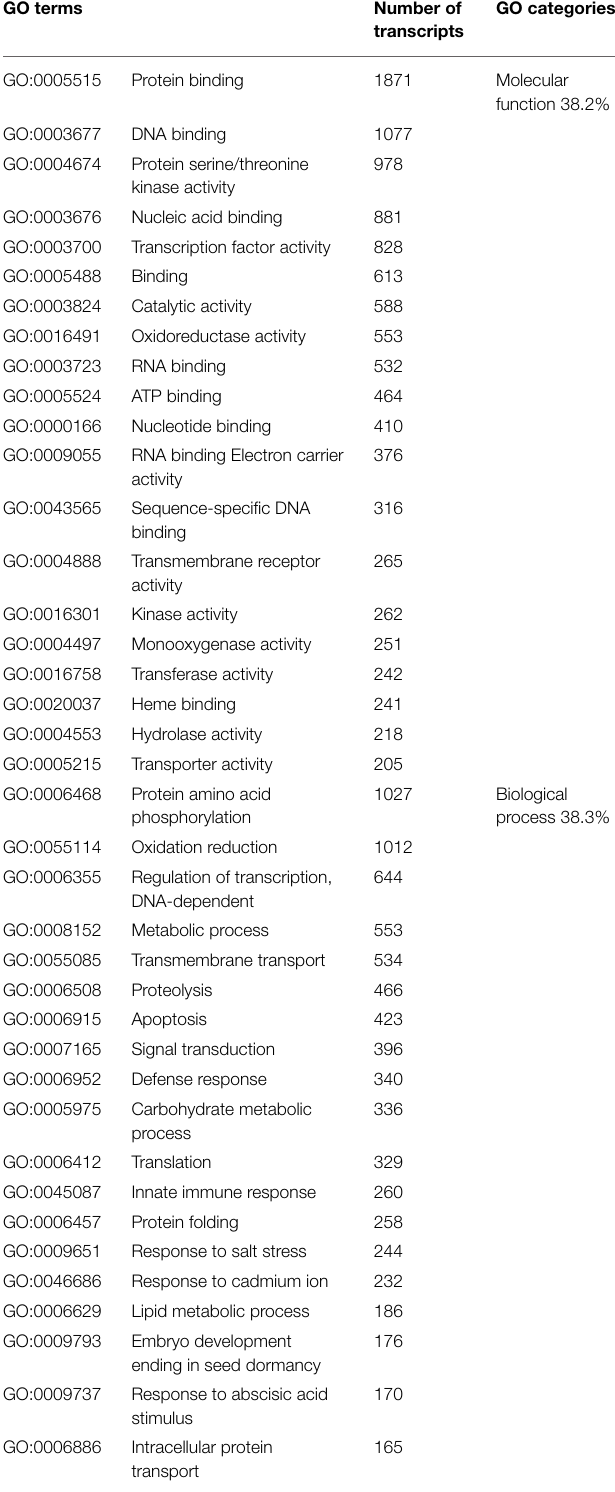
TABLE 3 | List of the top 20 gene ontology (GO) terms the most represented among the annotated transcripts from cut and garden roses, for each of three main GO categories.